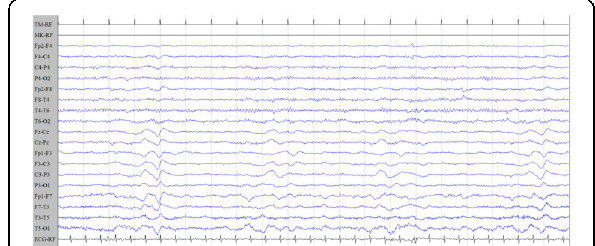
Fig. 1 (abstract P188). Acute-phase EEG showing a clearly asymmetrical pattern, with slow waves in the left hemisphere together with a minor amplitude of the tracks respect to the contralateral ones